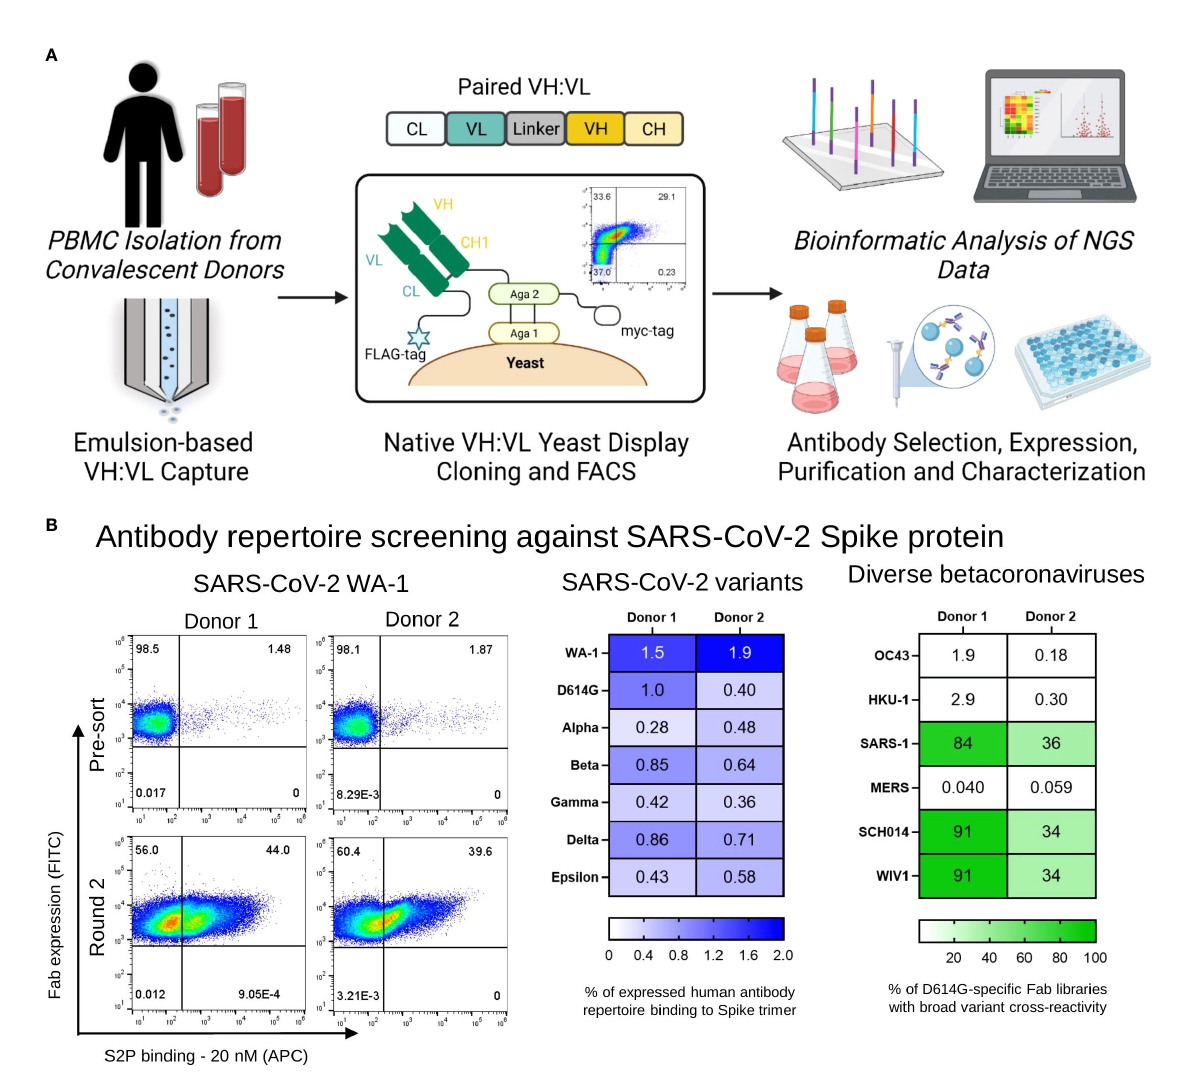
FIGURE 1 Functional screening of natively paired antibody repertoires from SARS-CoV-2 convalescent donors. (A) Natively paired yeast display library generation, FACS screenings and NGS-based antibodies selection and characterization. Peripheral memory B cells from two COVID-19 convalescent donors were isolated, and natively VH : VL antibody gene sequences were captured from CD27+ antigen-experienced B cells via emulsion overlap extension RT-PCR. Antibody libraries were constructed to clone the VH : VL antibody repertoire for yeast surface expression in a fragment antigen binding (Fab) format. Broadly recognized coronavirus probes were used for multiple rounds of fl uorescence-activated cell sorting (FACS) screening to map antibody responses against SARS-CoV-2 Spike antigens. Sorted yeast was sequenced with Illumina Next- Generation Sequencing (NGS), and NGS data was mined to interpret functional characteristics for each anti-SARS-CoV-2 Spike antibody in the dataset. A subset of antibodies was selected for expression as full IgGs and in vitro characterization . (B) ( Left ) Representative FACS analysis of yeast display repertoires screened for binding to the SARS-CoV-2 WA-1 Spike protein. ( Center ) Heat map of the percentage of human antibody repertoire binding to SARS-CoV-2 Spike trimers that recognize WA-1, D614G, Alpha, Beta, Gamma, Delta, and Epsilon variants. ( Right ) Yeast display libraries were enriched for 2 rounds against the D614G Spike trimer antigen, and the percentage of anti-D614G mAbs that were cross- reactive to coronavirus Spike trimers of WIV1, SCH014, OC43, MERS, SARS-1, and HKU-1 by antigen staining are shown in